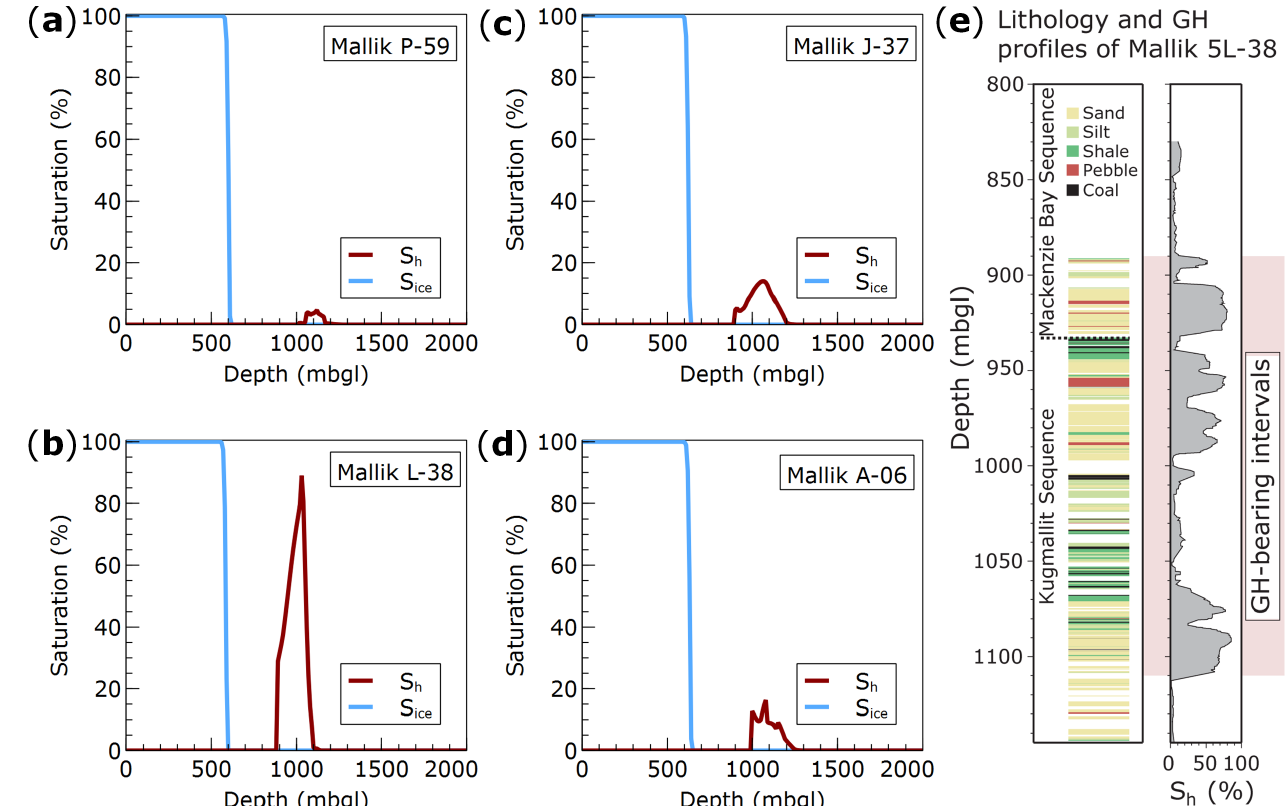
Figure 5. Simulated ice-bearing permafrost saturation (S ice ) and sub-permafrost gas hydrate satura- tion (S h ) profiles obtained for the respective locations of the Mallik P-59 ( a ); L-38 ( b ); J-37 ( c ); and A-06 ( d ) wells after a simulation time of 1 Ma; ( e ) lithology and S h profiles recorded at the Mallik 5L-38 well, modified after [79]. ( e ) presented with permission from Natural Resources Canada under the Open Government License—Canada version